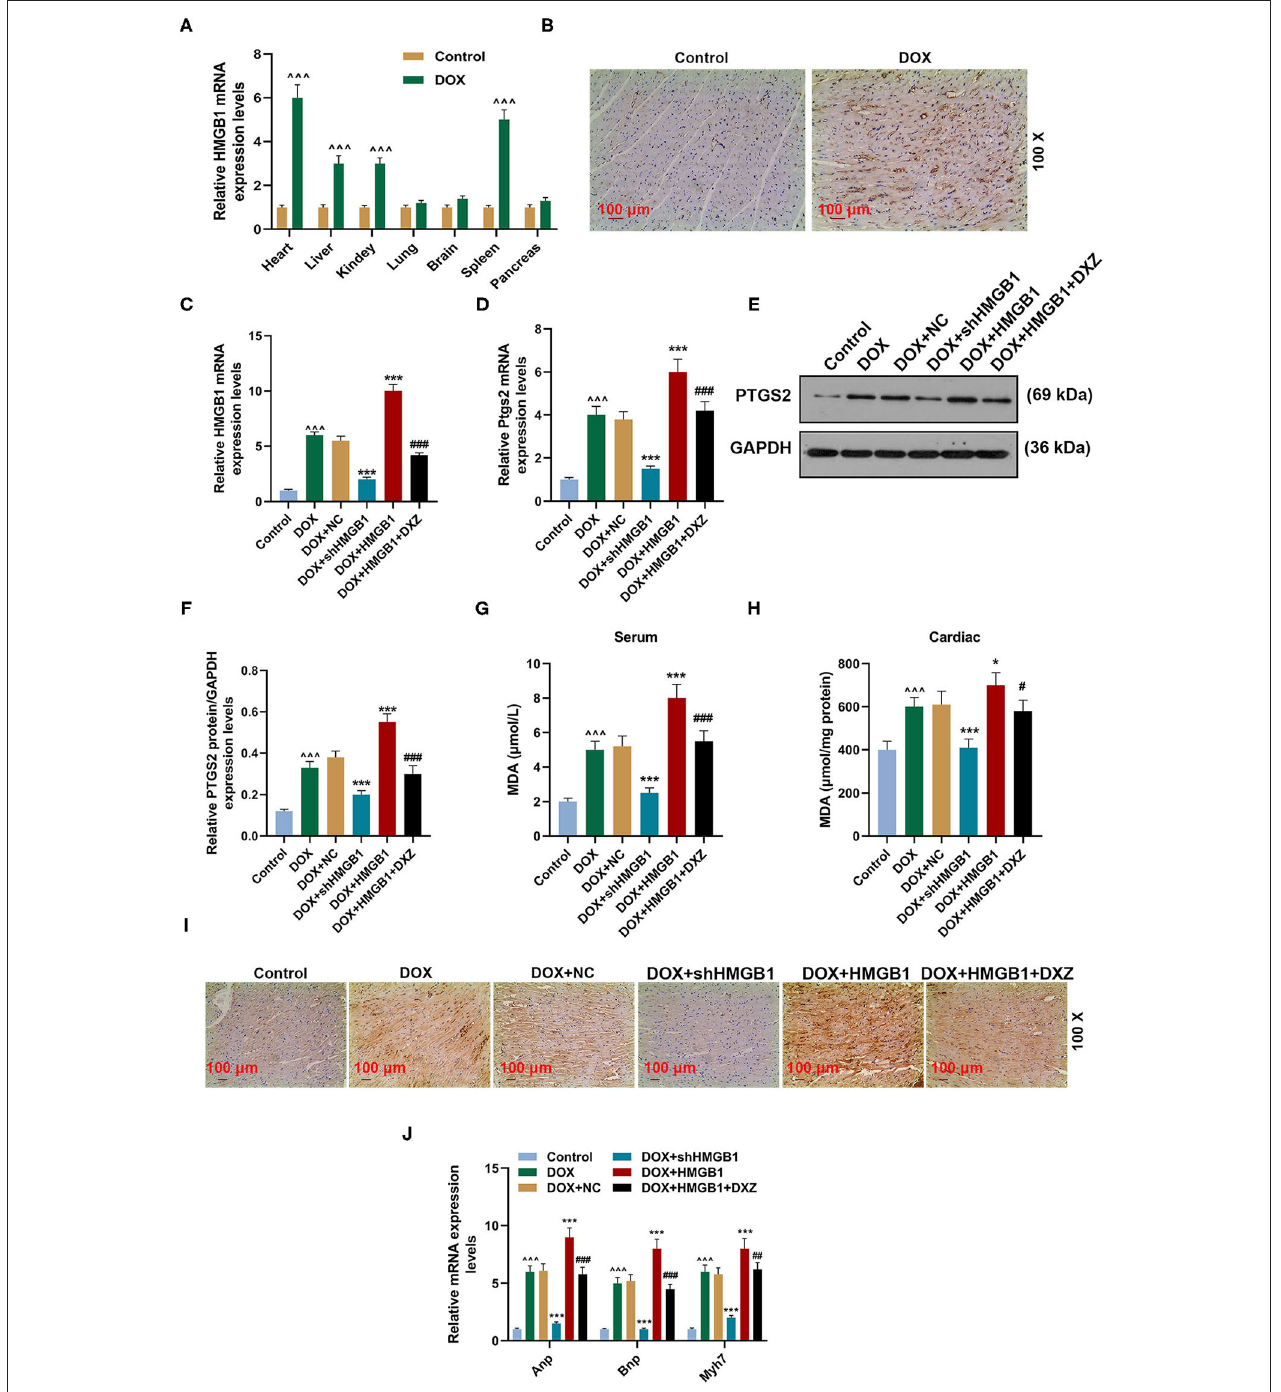
FIGURE 3 | HMGB1 is essential for DOX-induced ferroptosis and cardiotoxicity. (A) qRT-PCR analysis shows the mRNA expression level of HMGB1 in the indicated organs of rats after injection with saline (control) and DOX (20 mg/kg) with 10 rats in each group. (B) The expression of HMGB1 in heart tissues of rats from the control and DOX groups was detected by immunohistochemistry. Magnification: × 100. Scale bar = 100 µ m. Ten rats were used in each group. (C–F) qRT-PCR and WB analysis show the expression level of PTGS2 mRNA and protein and HMGB1 mRNA in rat heart tissues. Ten rats were used in each group. (G,H) The level of MDA in the serum and cardiac tissue of rats was measured by a lipid peroxidation MDA assay kit. Ten rats were used in each group. (I) The expression of 4-HNE in the heart tissues of rats from the control, DOX, DOX + NC, DOX + shHMGB1, DOX + HMGB1 and DOX + HMGB1 + DXZ groups was detected by immunohistochemistry. Magnification: × 100. Scale bar = 100 µ m. Ten rats were used in each group. (J) The expressions of ANP, BNP, and MYH7 in heart tissues of rats were calculated by qRT-PCR. Ten rats were used in each group. ∧∧∧ P < 0.001 vs. control. * P < 0.05, *** P < 0.001 vs. DOX. # P < 0.05, ## P < 0.01, ### P < 0.001 vs. DOX + HMGB1. Each experiment was repeated three times. HMGB1: high mobility group box 1; MDA: malondialdehyde; 4-HNE: 4-hydroxynonenal.